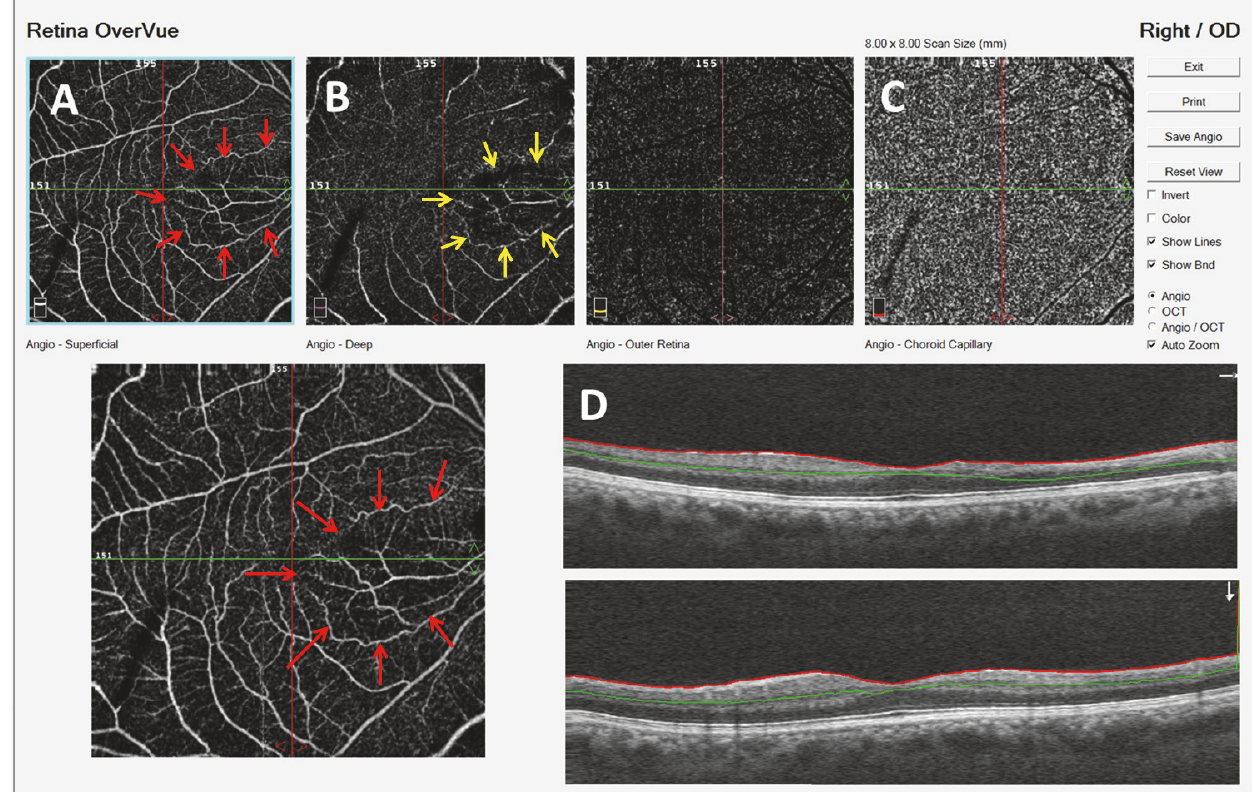
Figure 2: OCT angiography was performed 10 months later. Wedge-shaped area of capillary nonperfusion was revealed in both the superficial (A) and deep (B) retinal capillary plexus in area supplied by the cilioretinal artery and the choriocapillaris (C) was not